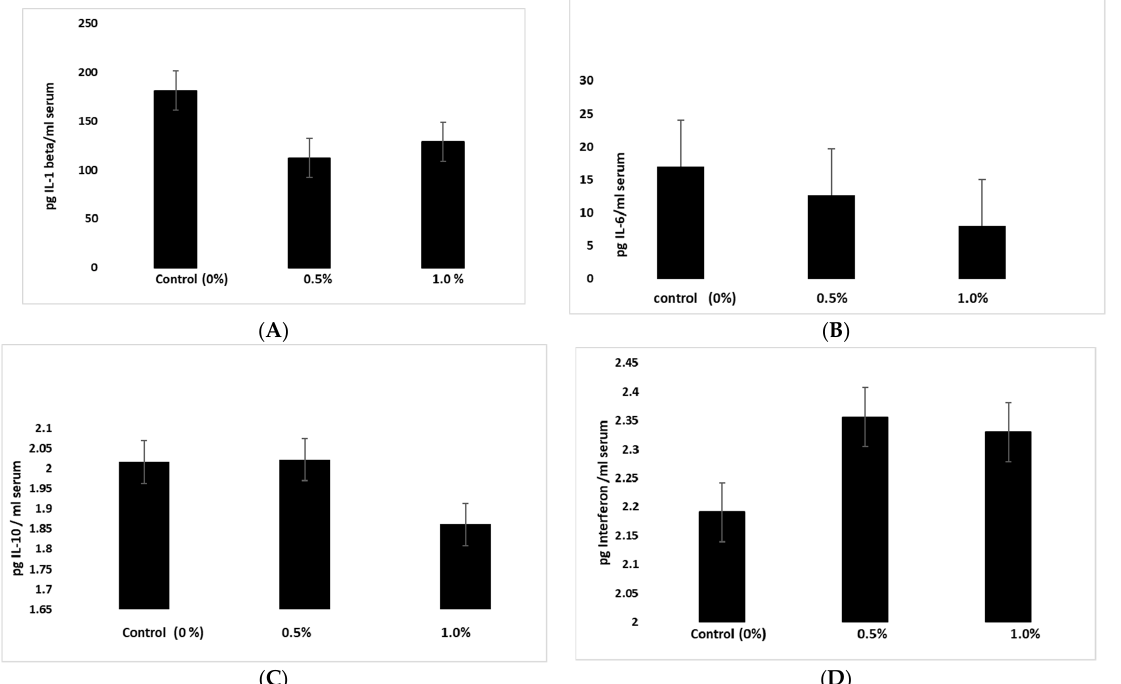
Figure 8. TurmiZn modulates levels of cytokines in broilers fed at 0 to 1% w/w inclusion rates for 6 weeks. ( A ): IL-1 beta levels; ( B ): IL-6 levels; ( C ): IL-10 levels; ( D ): Interferon levels. Values are mean ± standard error of mean. ( A ) IL-1 beta levels; ( B ) IL-6 levels; ( C ) IL-10 levels; ( D ) Interferon levels. Values are mean error of